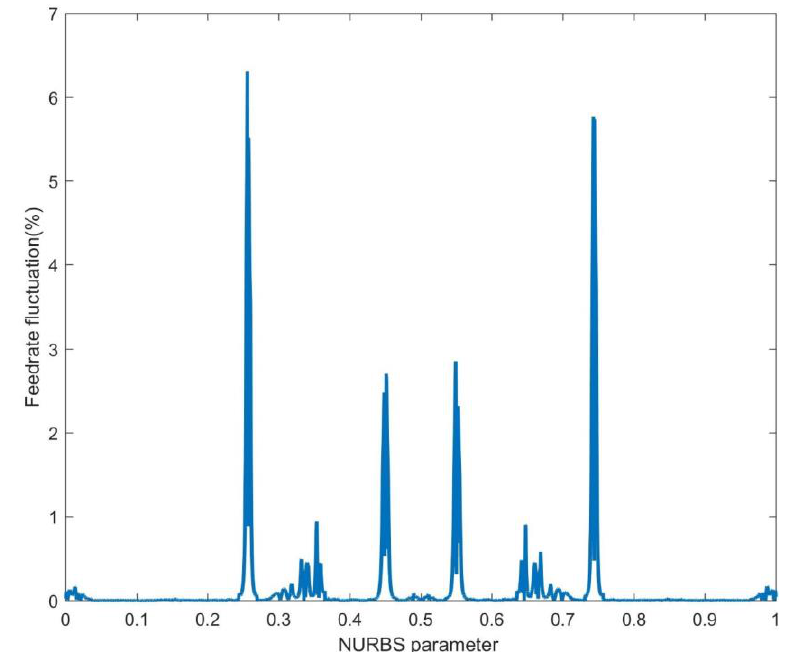
Figure 8. The feedrate fluctuation of the second-order adaptive feedrate method (SAM).